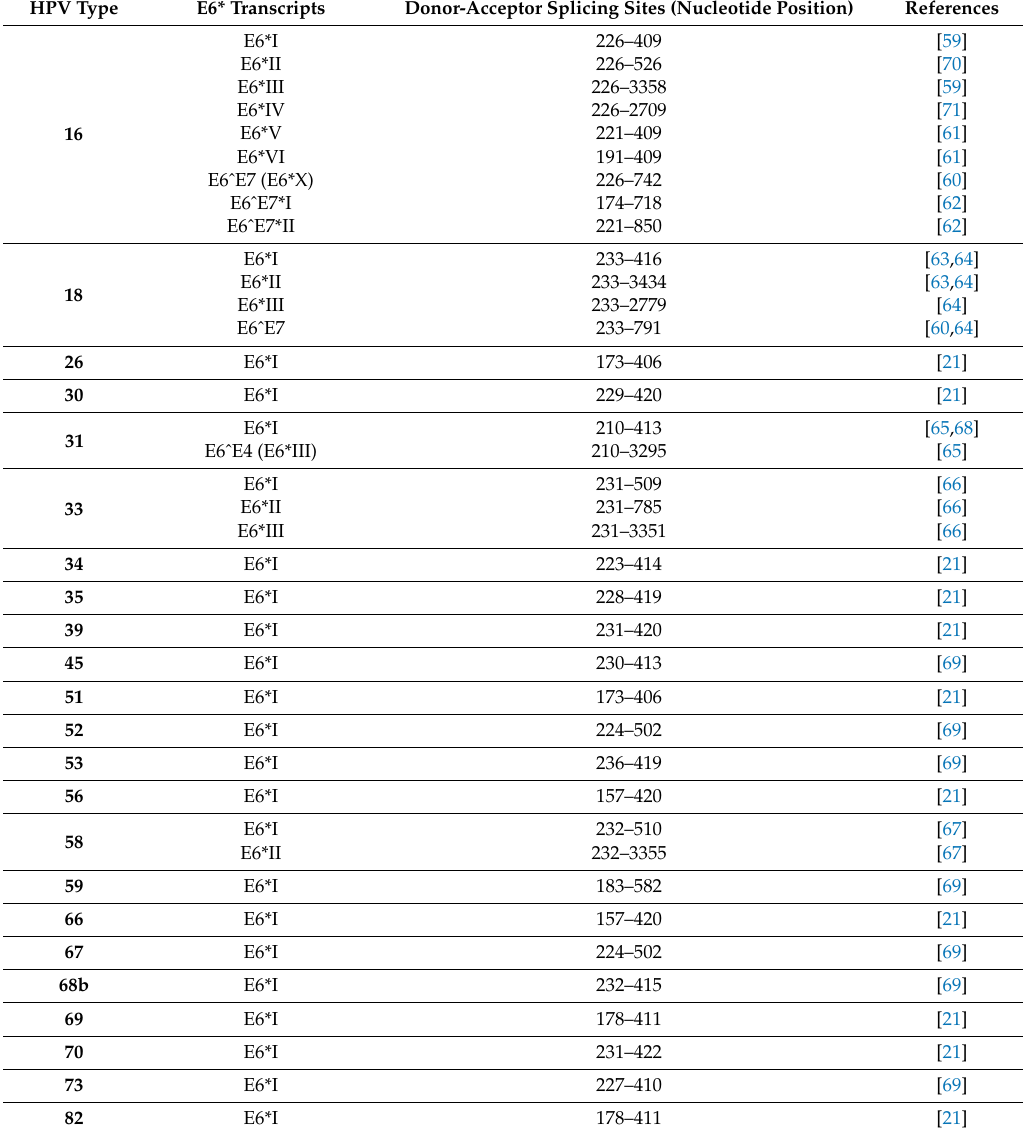
Table 1. Transcripts derived from alternative splicing within the E6 open reading frame (ORF). The table summarizes the E6* isoforms for 23 HPV types where alternative splicing has been observed. The detailed donor and acceptor splicing sites for each E6 truncated transcript are enlisted